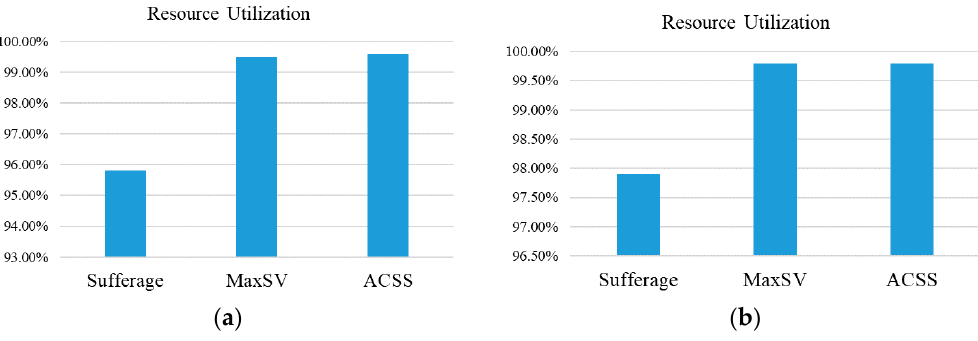
Figure 6. The ratio of Resource Utilization in the ACSS scheduling algorithm for ( a ) n = 4 and number of tasks = 50 and ( b ) n = 4 and number of tasks = 100.